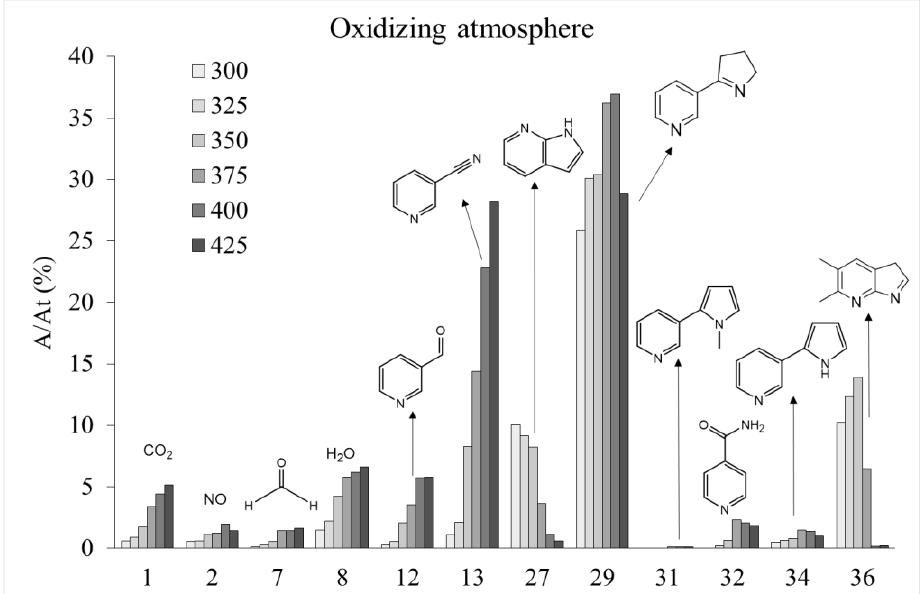
Figure 10. % area vs temperature of the majority compounds detected in the pyrolysis of NNN under air atmosphere. Carbon dioxide (1), nitric oxide (2), formaldehyde (7), water (8), 3-pyridinecarboxaldehyde (12), 3-pyridinecarbonitrile (13), 1H-pyrrolo [2,3-b] pyridine (27), myosmine (29), nicotiryne (31), 4-pyridinecarboxamide (32), nornicotiryne (34) y 5,6-dimethyl-3H-pyrrolo [2,3-b] pyridine (36).